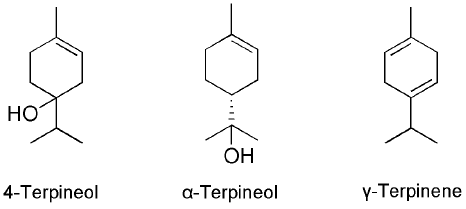
Figure 2. The other three monoterpenoids from the essential oil of A. lavandulaefolia